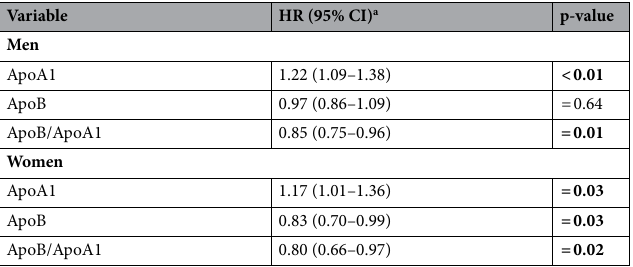
Table 4. Sex-stratified, multivariable Cox regression analysis with HR for incident DD in relation to ApoA1, ApoB and the ApoB/ApoA1 ratio, adjusted for age at baseline, hypertension, DM, alcohol consumption, BMI, manual work, and smoking. BMI body mass index, CI confidence interval, DD Dupuytren’s disease, HR Hazard Ratio. Bold values indicating p < 0.05. a HR are expressed as per one SD increase of respective Z-score converted